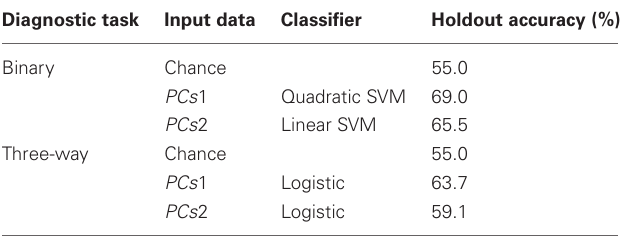
Table 4 | Holdout Dataset results: accuracies for binary and three-way diagnosis on the 171 participant Holdout Dataset using personal characteristic input